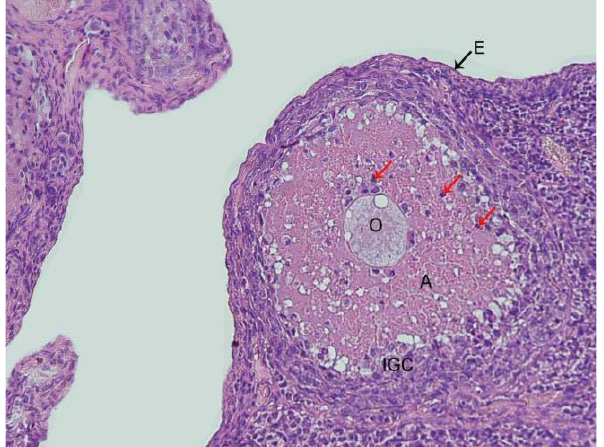
Fig-3: Photomicrograph of Graafian follicle in ovarian cortex of experimental group B showing irregular granulose cell layer (IGC), central oocyte (O), pyknotic granulosa cells pulled away from basement membrane (red arrows) and epithelium (E), (H & E,